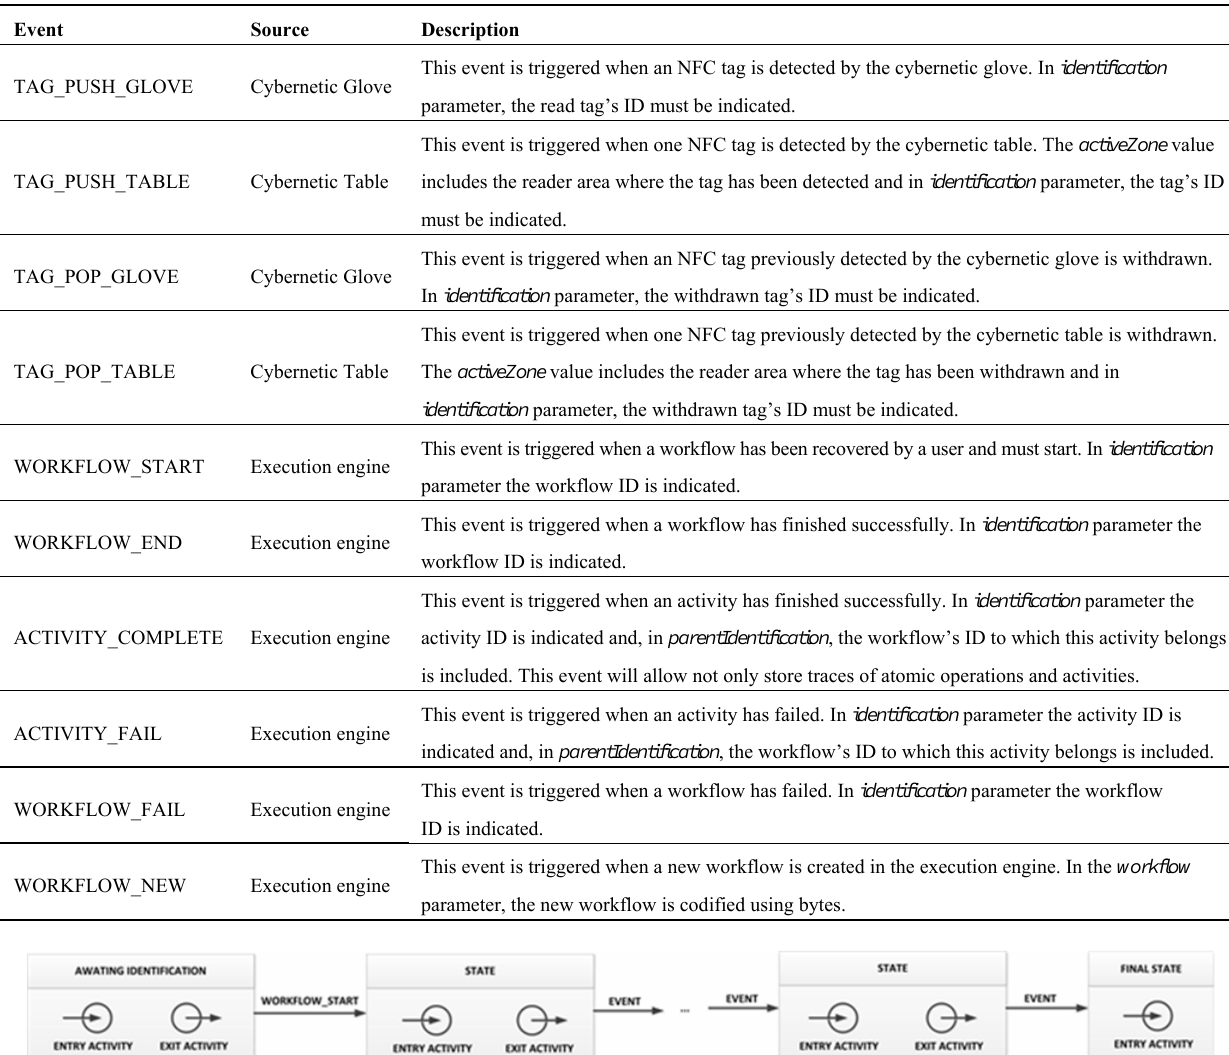
Table 3. Events currently supported in the TF4SM.